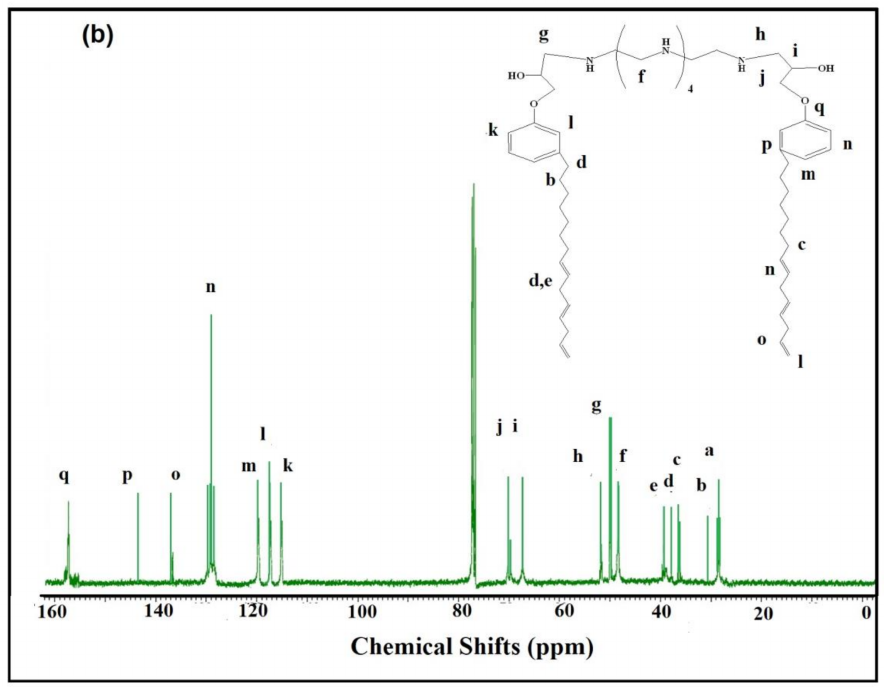
Figure 3. 13 C-NMR spectra of ( a ) HPHI and ( b ) DCHI.